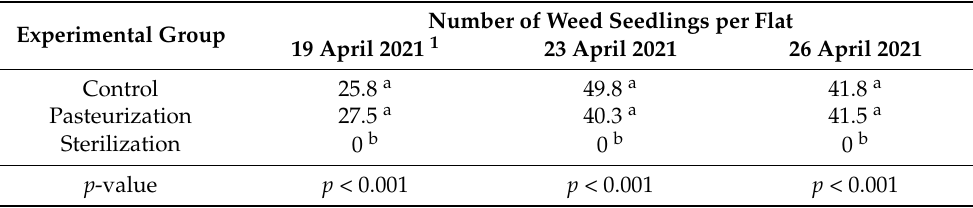
Table 9. Effects of compost treatments on the weed abundance ( n = 4). Tomato seeds were planted on 12 April 2021.